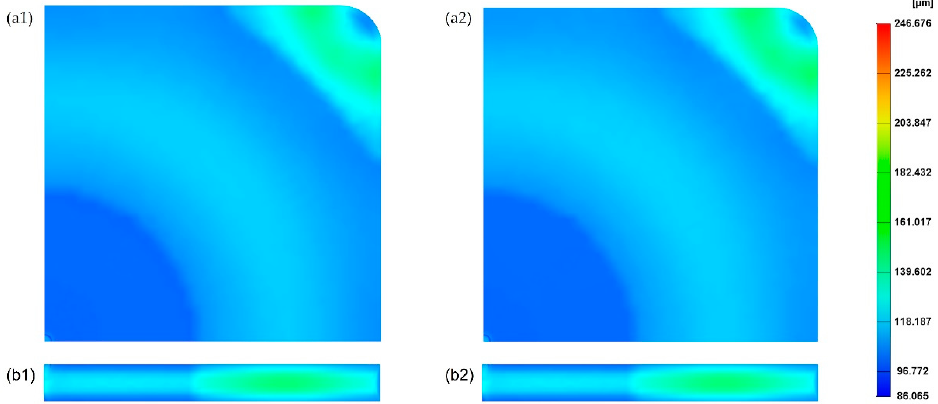
Figure 6. Cell size distribution on the surface and cross-section of the MuCell ® part considering